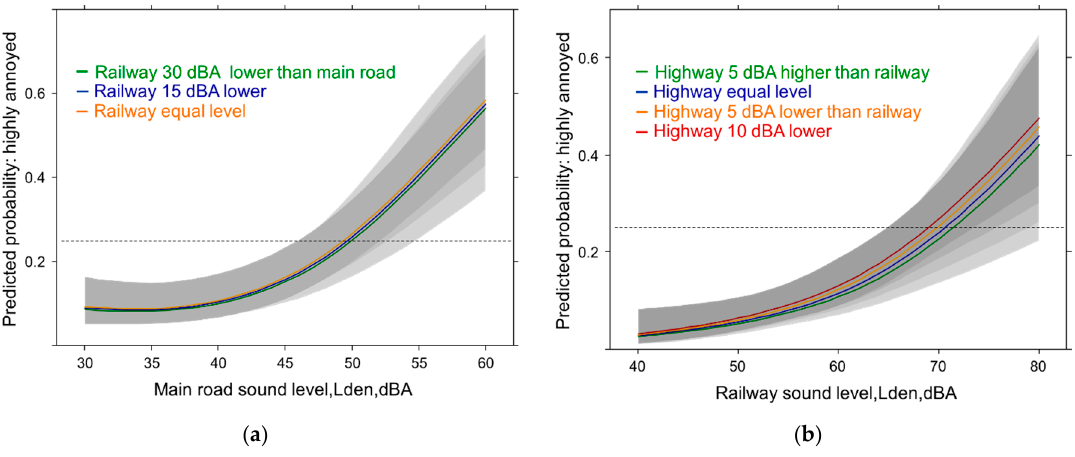
Figure 9. Predicted proportion of high source annoyance associated with level differences to the other source (in dBA). ( a ) Main road & railway; ( b ) Railway & highway. Adjusted for age, sex, education, noise sensitivity, health status and the other sound source difference.